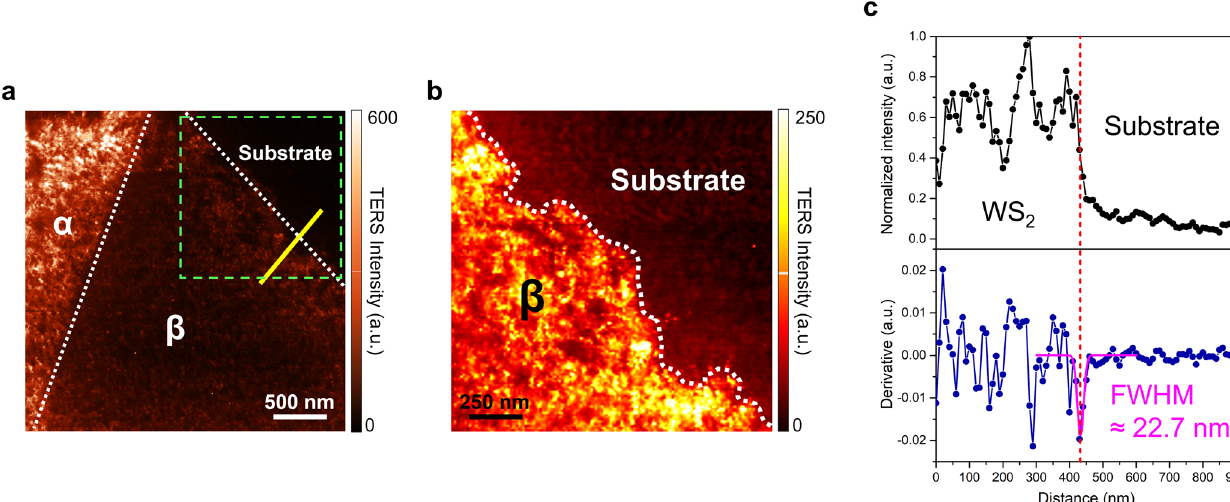
Fig. 2 Spatial resolution of TERS imaging. a TERS map of A 1g peak area intensity for monolayer WS 2 with background (acquisition time for point: 0.5 s). The measured region is the same as the confocal Raman map. b Magni fi cation of the green dashed square in the TERS image in ( a ). The white dotted curve indicates the sample edge. c Normalized TERS intensity pro fi le along a yellow solid bar and the derivative of the intensity pro fi